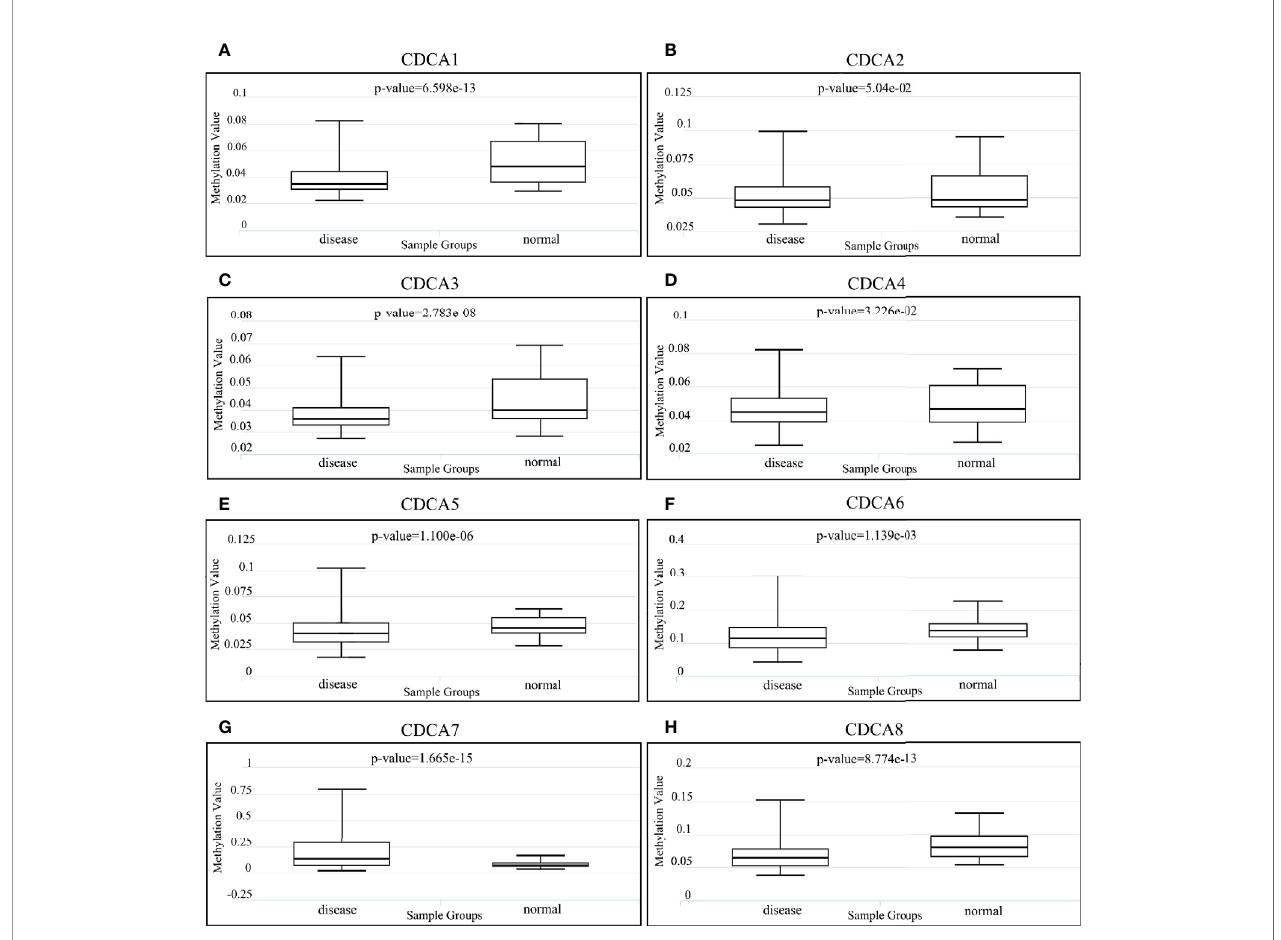
FIGURE 7 | Methylation analysis of CDCAs via DiseaseMeth 2.0. Methylation values for (A) CDCA1, (B) CDCA2, (C) CDCA3, (D) CDCA4, (E) CDCA5, (F) CDCA6, (G) CDCA7, and (H)